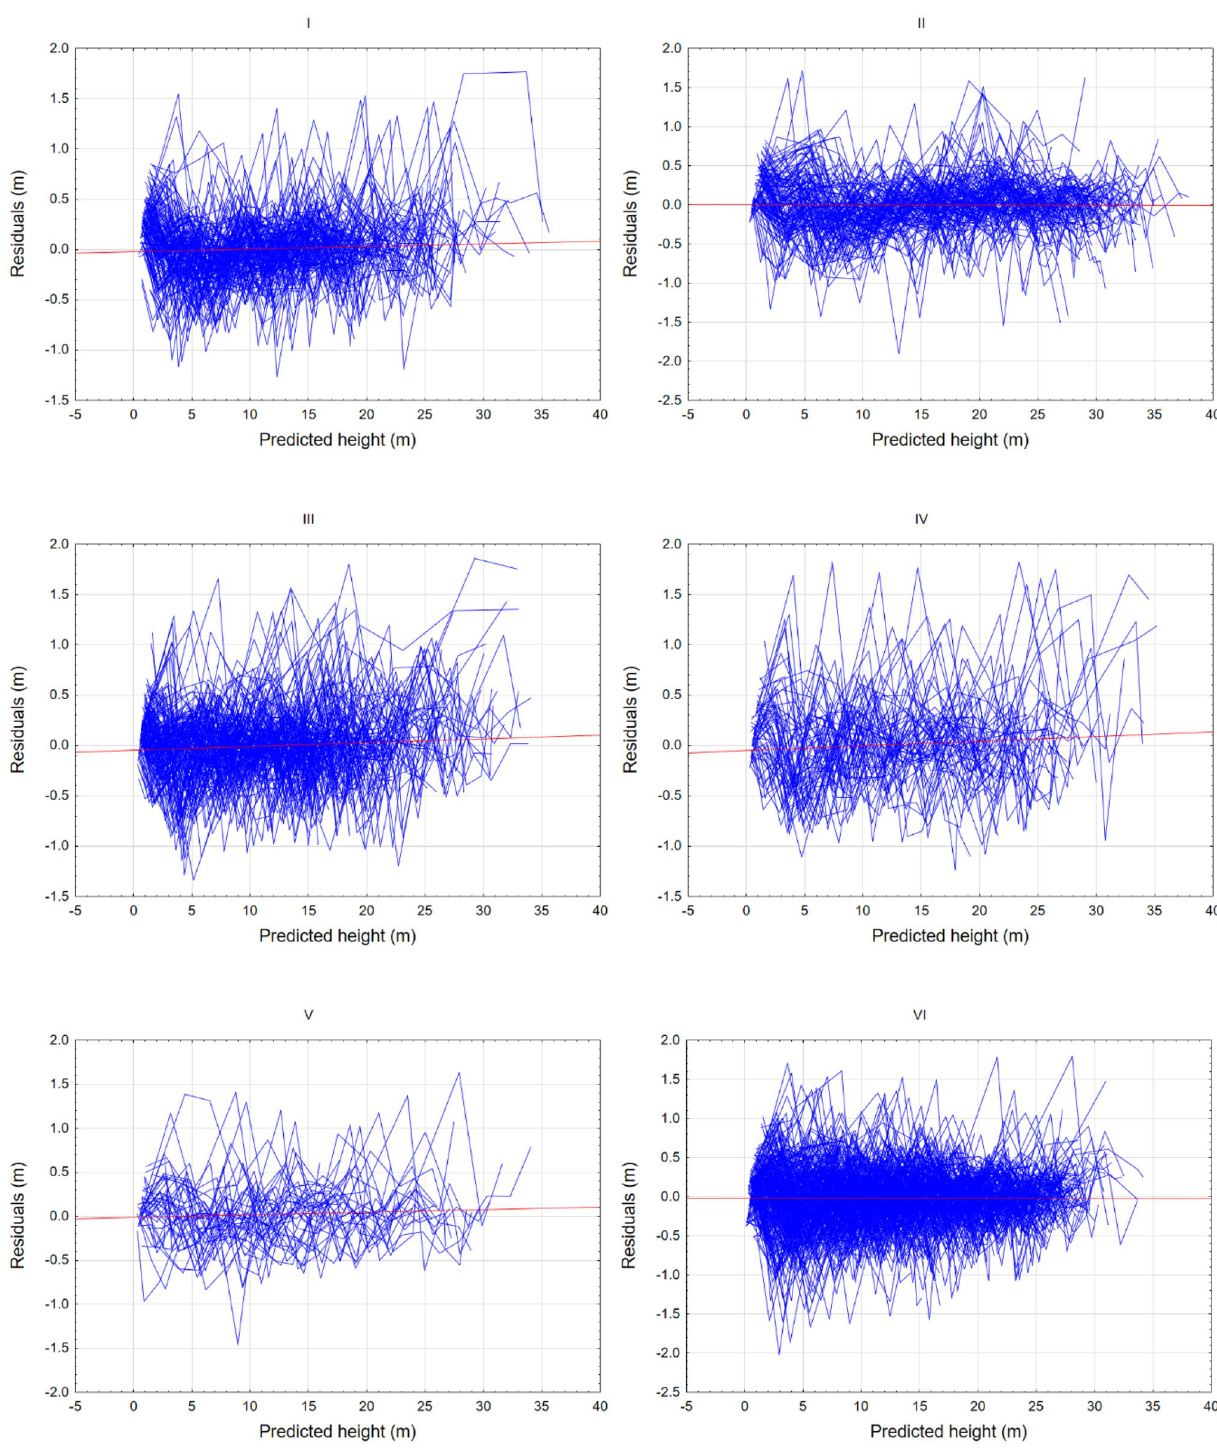
Figure 2. Relationship between residual and predicted height using the site index model for Scots pine in Poland developed using nonlinear fixed-effect modelling approach with the parameters expanded as a function of regions